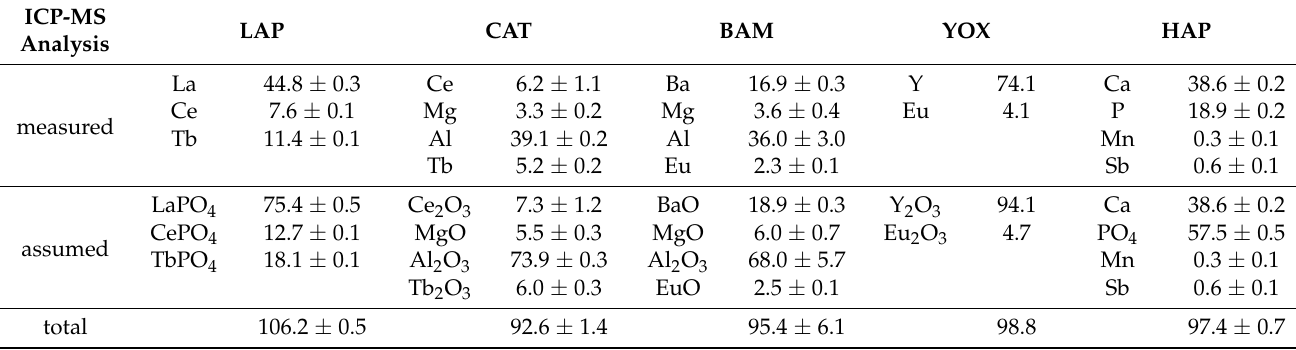
Table 1. Chemical compositions of the phosphors as determined by ICP-MS after dissolution in a microwave-assisted acid digestion process, shown in mass percentages with standard deviations of repeated measurements. LAP 1 , CAT, and BAM were dissolved in H 3 PO 4 , YOX was dissolved in aqua regia (3:1 ratio of HCl and HNO 3 ) and HAP in HF. ICP-MS analysis